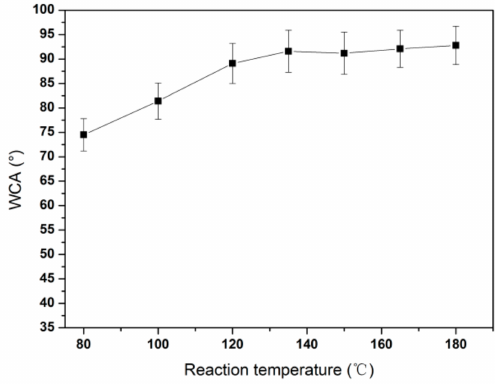
Figure 5. The influence of reaction temperature for hydrothermal reduction upon WCA values for HRGO-APS